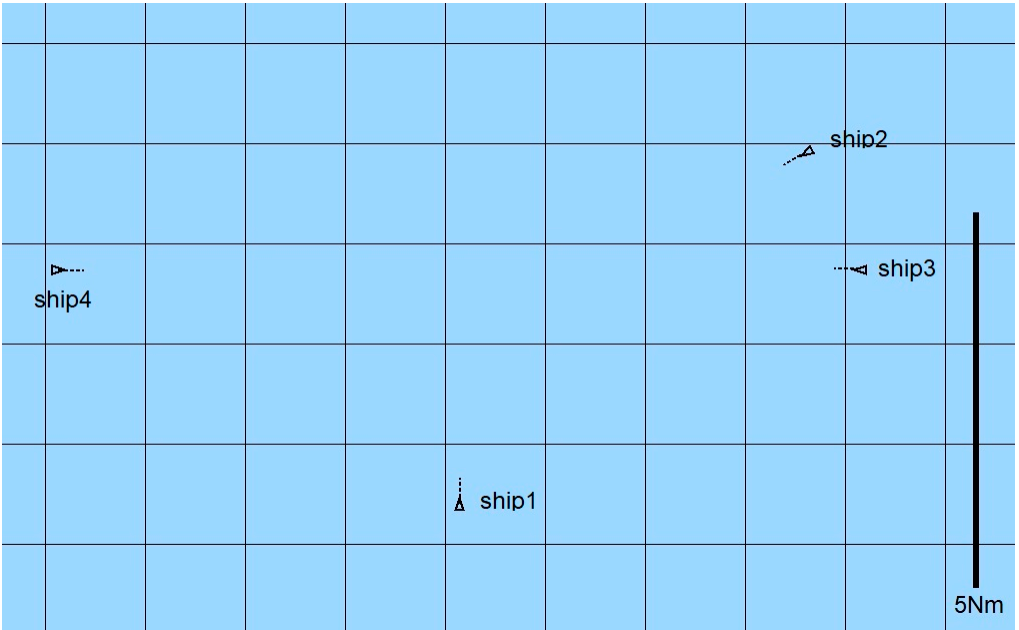
Figure 8. Scenario of a collision situation encountered by four ships—Example